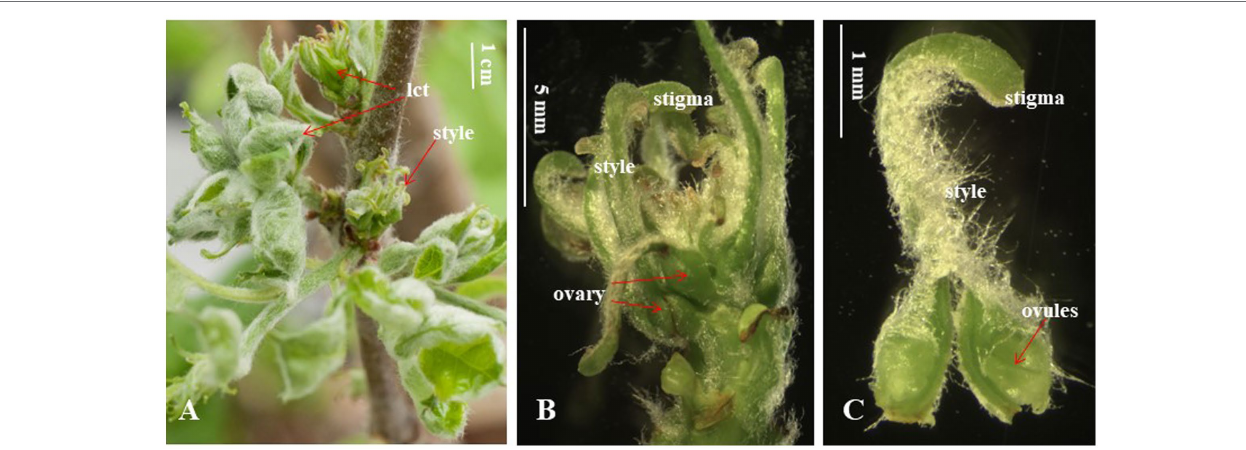
FIGURE 4 | Flowers of apple transgenic plants over-expressing miR172. (A) Floral inflorescences show abnormal flowers consisting of leaf-like carpel tissues (lct), style, and stigma, but no sepals, petals, or stamens. (B) A florescence of (A) with leaf-like carpels removed reveals separate carpels consisting of ovary, style, and stigma. (C) A single carpel removed from the inflorescence in (B) reveals two ovules after cutting the ovary open (This figure is re-produced from Yao et al.,